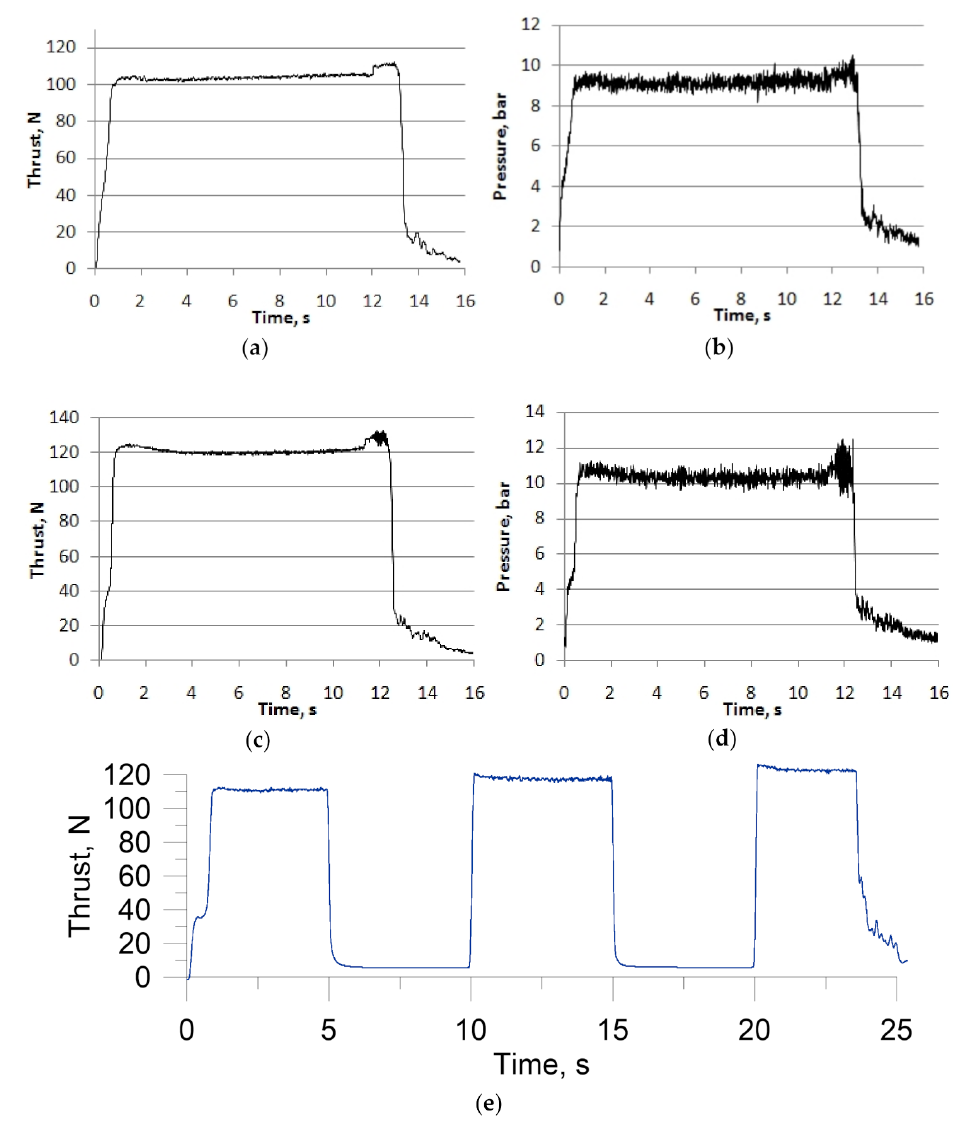
Figure 2. Selected results of hot fire tests of hybrids using 98% HTP and HTPB as propellants conducted at IoA during 2012–2013 [87,99]: ( a , b ) thrust and chamber pressure profile of the single hot fire test no. 1; ( c , d ) thrust and chamber pressure profile of the single hot fire test no. 2; ( e ) thrust profile of 5 s on/5 s off pulse mode